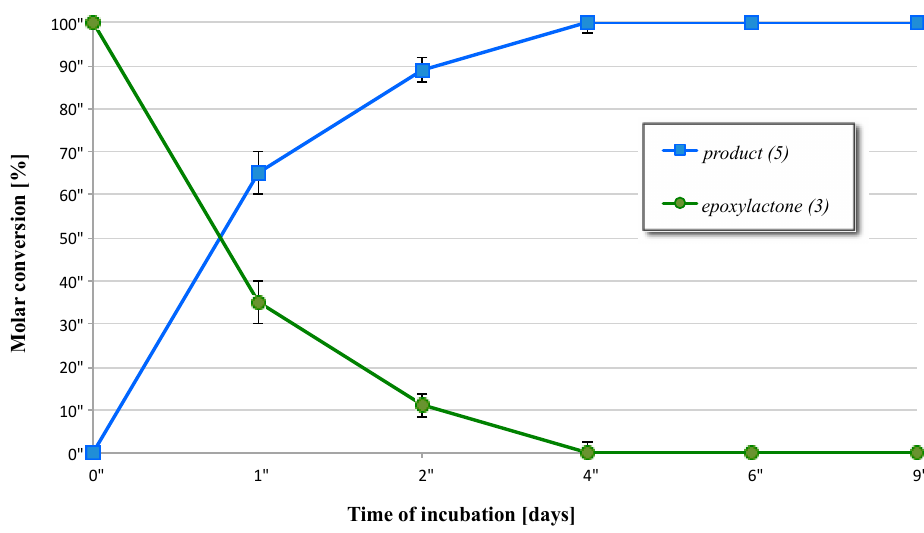
Figure 5. Time dependence of transformation of lactone ( 3 ) in D. igniaria KCh6670 culture